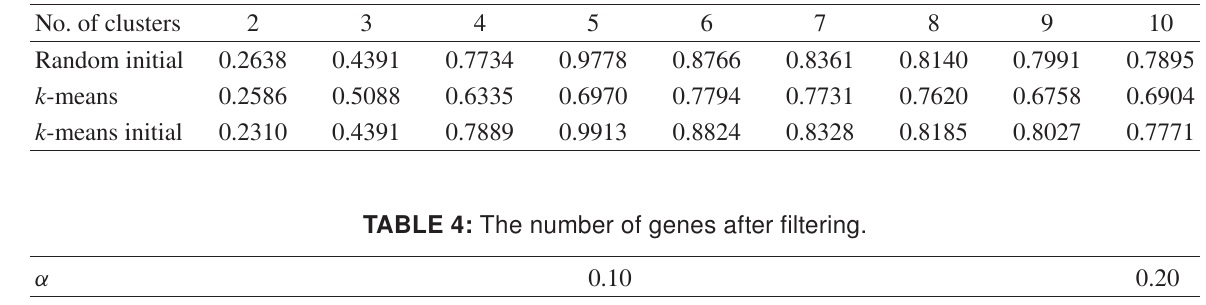
TABLE 3: The values of AARI for different clustering methods on synthetic data.